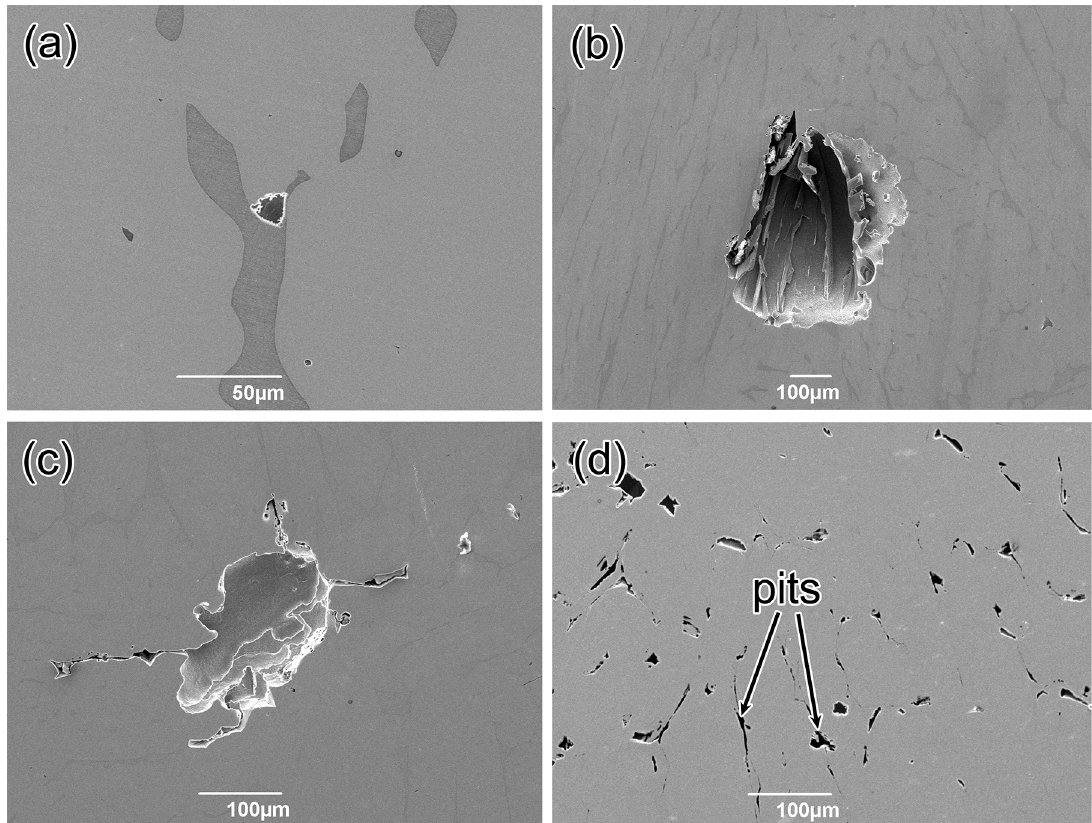
Figure 7. The micrographics of different Z3CN20.09M specimens after the electrochemical tests (a) solid solution, (b) 350℃, (c) 450℃, (d) 500℃